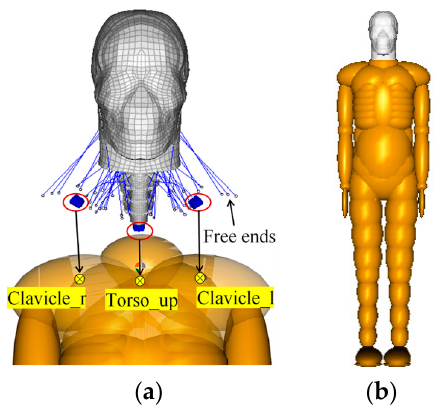
Figure 2. ( a ) Schematic diagram of the coupling process; ( b ) the full-scale coupled pedestrian computational biomechanics model (CPCBM).